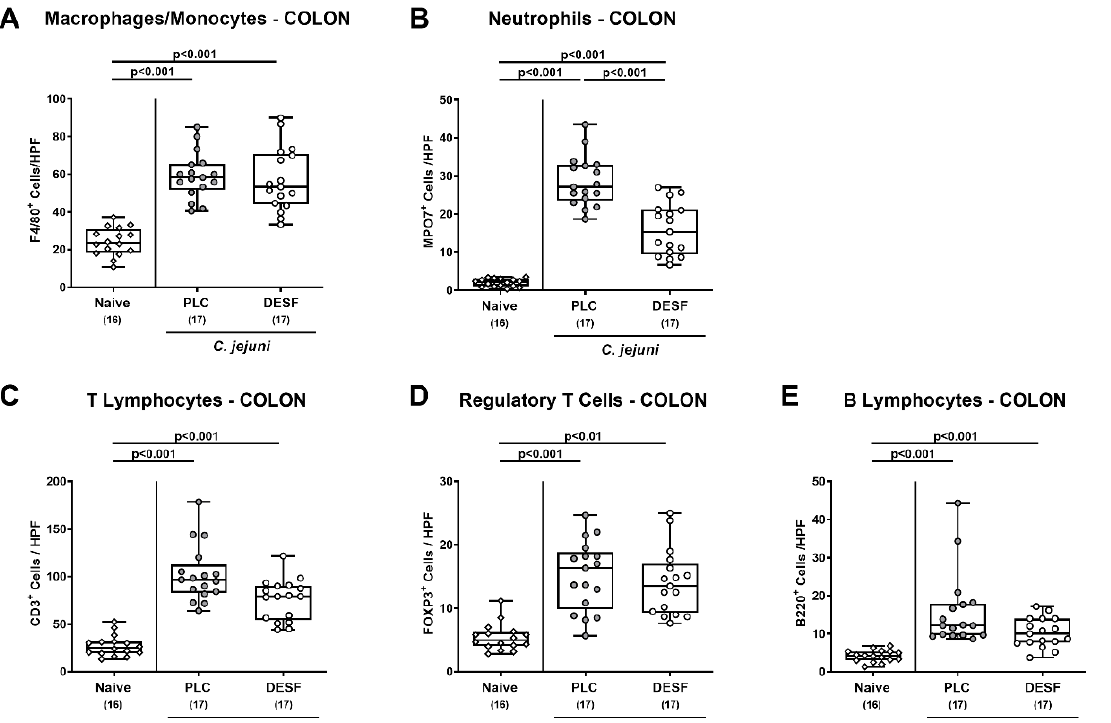
Figure 4. Immune cell responses in the colon following C. jejuni infection of microbiota-depleted IL-10 − / − mice that had been pretreated with deferoxamine. Microbiota-depleted IL-10 − / − mice were subjected to desferoxamine (DESF, white circles) pretreatment via the drinking water starting 7 days prior infection or received autoclaved tap water only (PLC; grey circles). On days 0 and 1, mice were perorally infected with C. jejuni strain 81-176. On day 6 post-infection, distinct immune cell populations were assessed in colonic paraffin sections by quantification of ( A ) F4/80 + macrophages and monocytes, ( B ) MPO7 + neutrophils, ( C ) CD3 + T lymphocytes, ( D ) FOXP3 + regulatory T cells, and ( E ) B220 + B lymphocytes within the colonic mucosa and lamina propria following immunohistochemical staining with respective antibodies. Indicated are the medians of positively stained cells within six representative high-power fields (HPF, 400 × magnification). Uninfected and untreated mice served as negative controls (white rhombus). Whiskers indicating the total range, boxes indicating the 25th and 75th percentiles of the medians (black bars inside boxes), significance levels ( p values) calculated by the ANOVA test and Tukey’s post-correction ( A , B , D ) and the Kruskal–Wallis test with Dunn’s post-correction ( C , E ), and the total numbers of analyzed mice (in parentheses) are given. Shown data were pooled from three independent experimental sets.